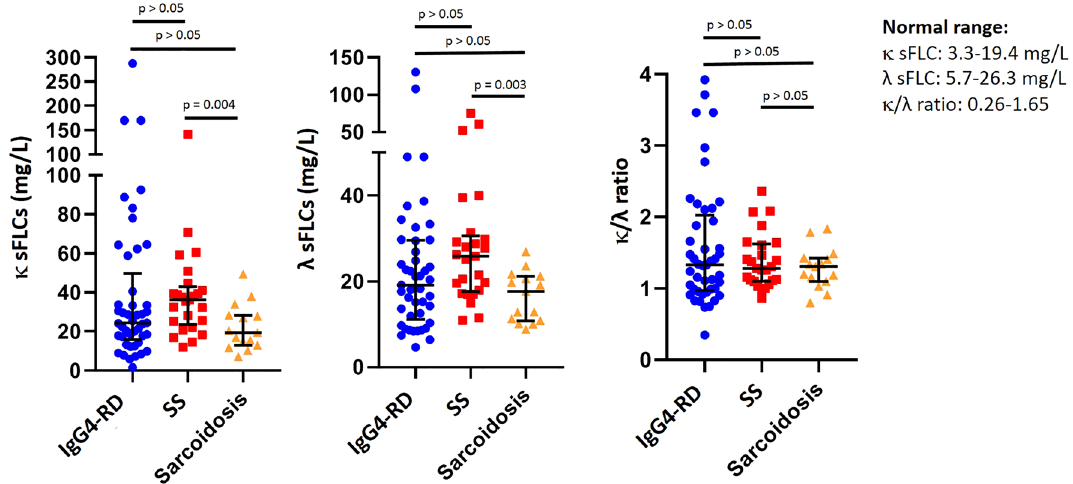
Figure 1. Levels of κ and λ serum free light chains and the κ/λ ratio were not different among IgG4-related disease (n = 45), Sjögren’s syndrome (n = 25) and sarcoidosis (n = 15) patients (median with interquantile